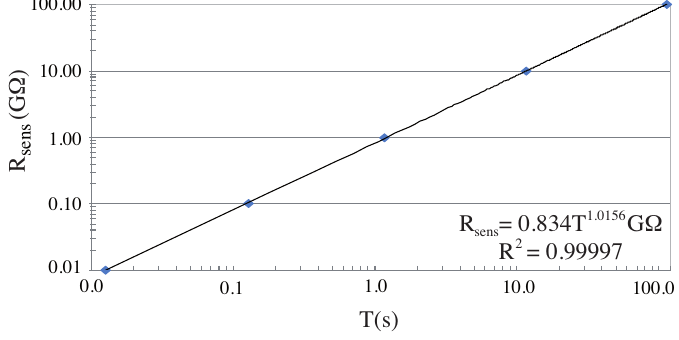
Figure 2. Experimental relation between R sens and T using the proposed AC method. As seen, the obtained period T is directly related to R sens in the whole measurement range [10 M Ω , 10 G Ω ] and can be linearly